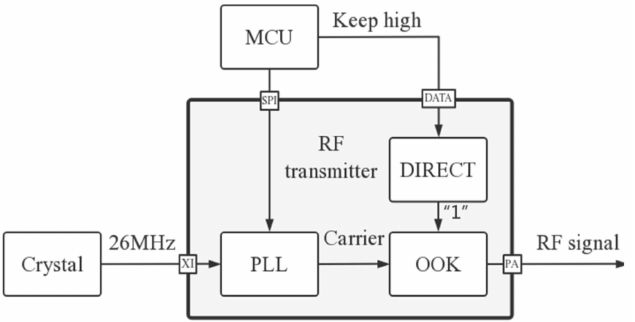
Figure 4. Transmitter configuration of fractional-N PLL as RF source.